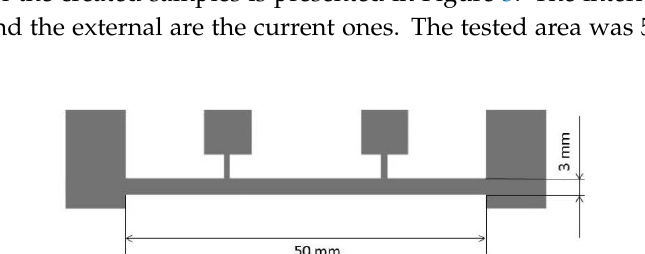
Figure 3. Geometry and dimensions of the test structure created using the PVD process on textile substrates.